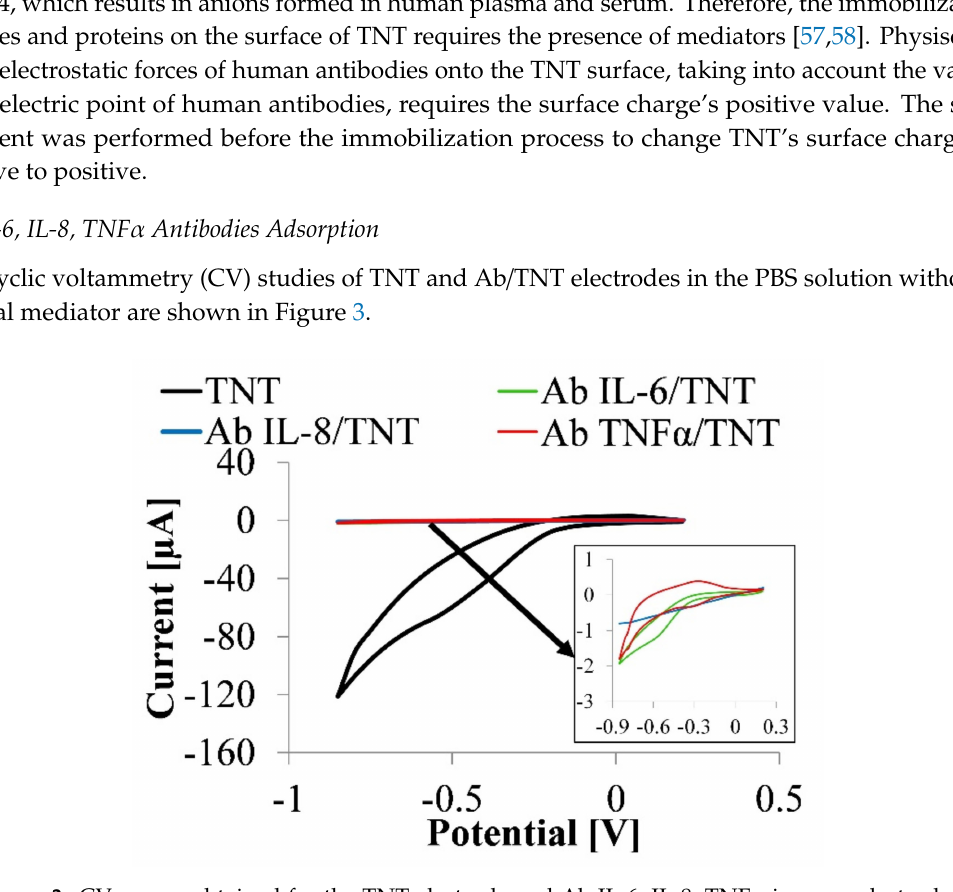
Figure 3. CV curves obtained for the TNT electrode and Ab IL-6, IL-8, TNF α immunoelectrode in 0.01 M PBS solution without any external